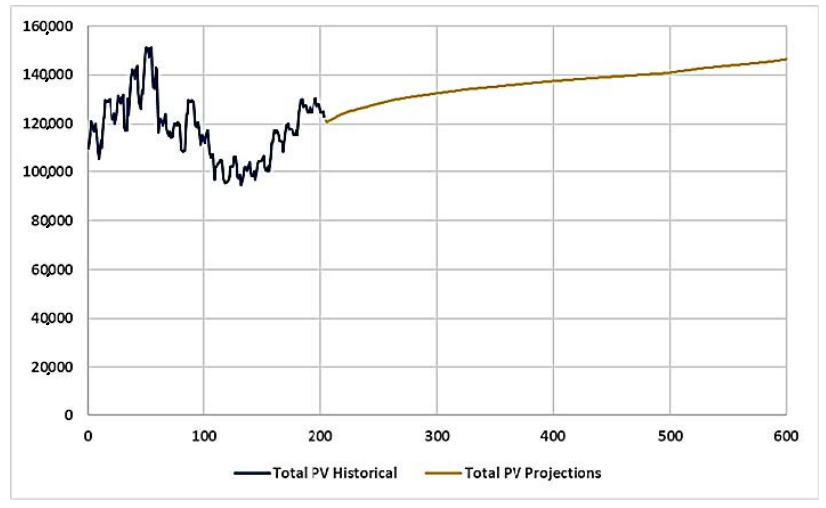
Figure 22. The PV traffic projections of case study 1.